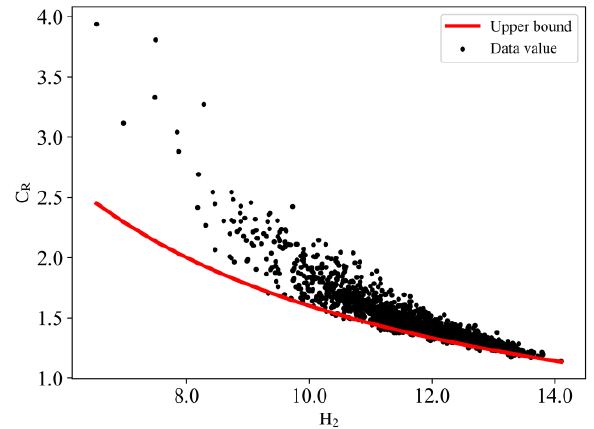
Figure 14 The upper bound by H 2 and scatter plot of H 2 against C R obtained by LZMA